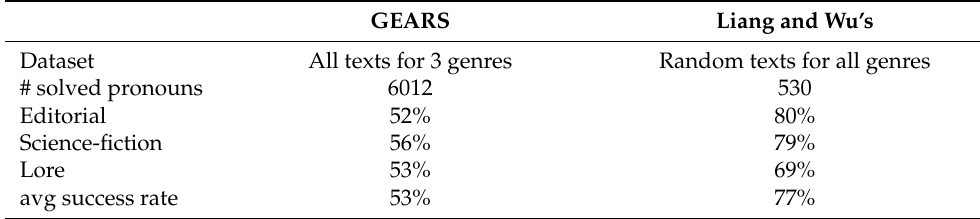
Table 5. Comparison of our algorithm against Liang and Wu’s (Hobbs’